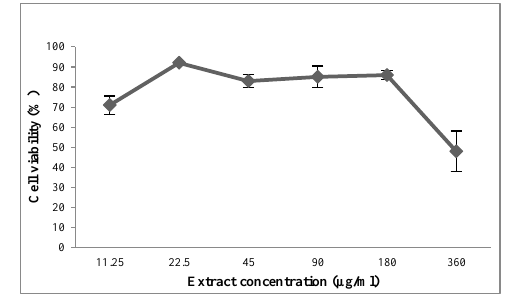
Figure 2: MCF-7 cancer cells viability after treated with C.